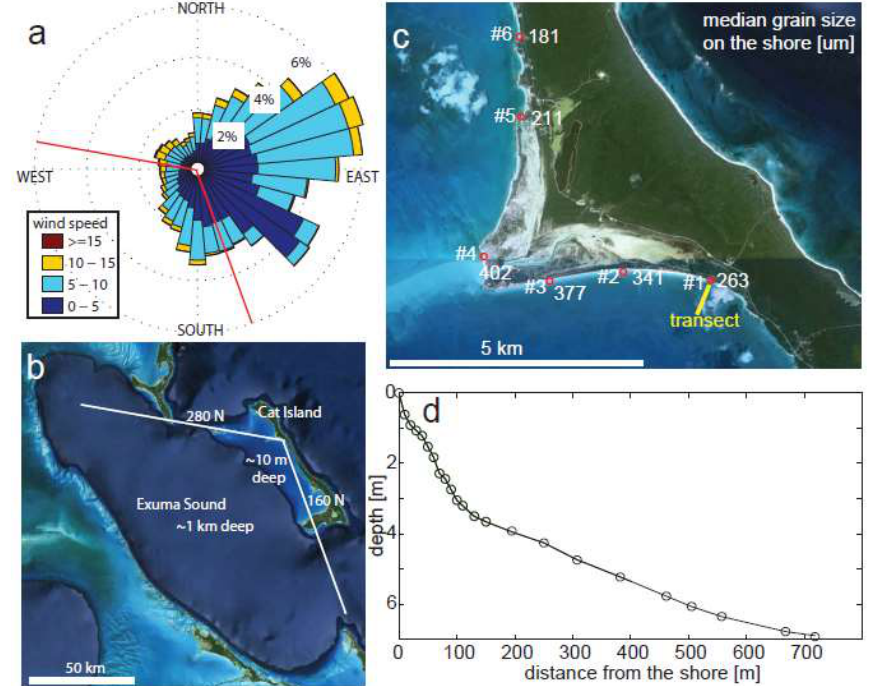
Figure 1. Geographic and environmental characterization of the study site. ( a ) Wind rose from a station ~400 km N-W of the study site, representative of the large-scale wind patterns in The Bahamas region. ( b ) Image of Cat Island and its shallow shelf. The lines identify the wave exposure of the study site, Pigeon Cay. Only winds blowing from the sector approximately between 160° and 280° N generate waves that impact the shore. ( c ) Detail of Pigeon Cay in Cat Island. Red dots indicate sampling sites along the beach, yellow line indicates the cross-shore transect. Numbers near the dots show the median grain size [µm] at each sampled locality. Images from GoogleEarth (NASA, DigitalGlobe 4/28/2013). ( d ) Depths along an 800 m long transect. The depths were measured using a rope from a kayak with a 10% error in depth and position.